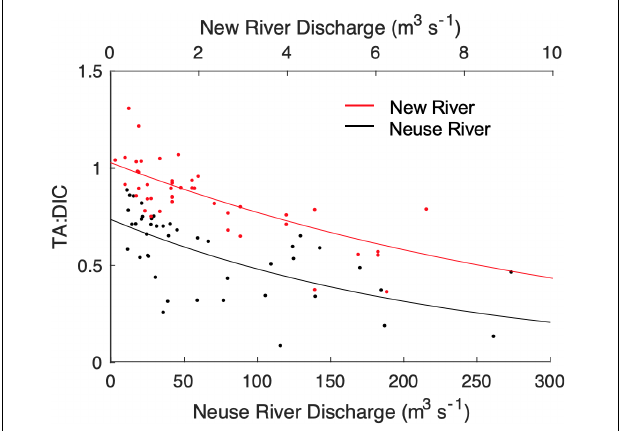
FIGURE 4 | Relationship between river endmember TA:DIC and discharge for the New (red points) and Neuse (black points) rivers. Exponential fits are of the form f (x) = a ∗ exp(b ∗ x), where the coefficients are a = 0.74 and b = –0.0043 for the Neuse River, and a = 1.03 and b = –0.086 for the New River. Water quality data (TA, pH, Temperature, Salinity) were obtained from STORET for the North Carolina Dept. of Environmental Quality site J7850000 (Neuse River near Ft Barnwell), and from sites 21NC01WQ-P0600000 and 21NC01WQ-P1200000 in the upper New River. Only matching pairs of TA, pH, temp, and salinity were used, yielding a relatively small set of data from 1990 to 1993. DIC was calculated from measured TA, pH, Temperature, and Salinity with CO2SYS. Matching discharge data were obtained from the USGS gage at Gum Branch for the New River (2093000), and the USGS gage at Kinston for the Neuse River